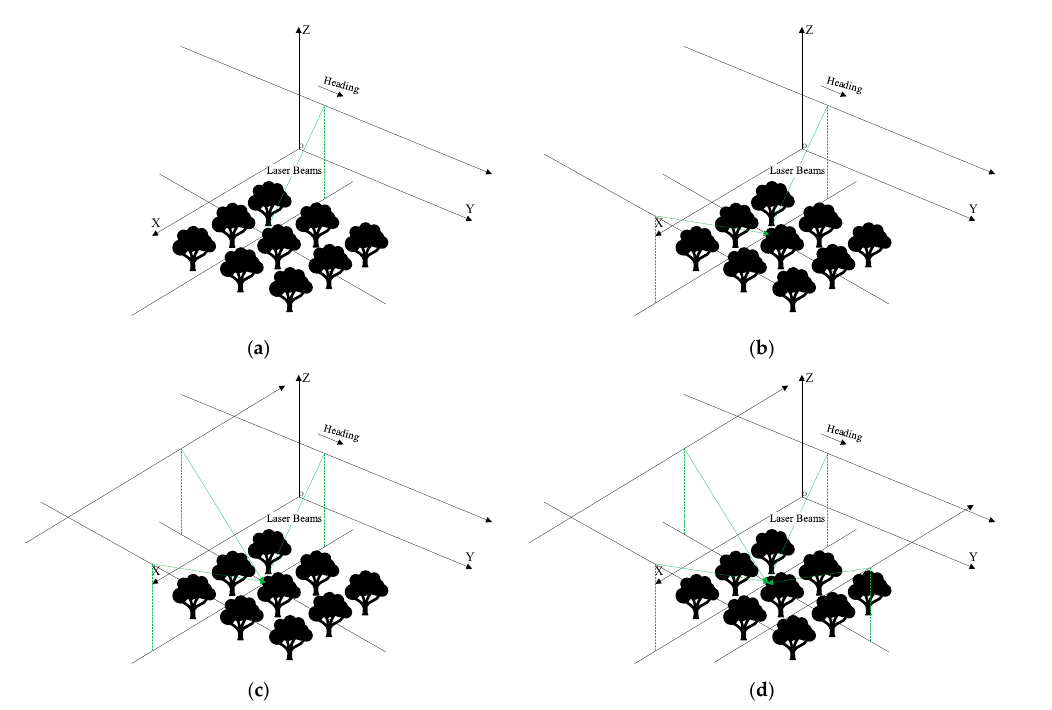
Figure 8. Schematic diagram of different scanning modes: ( a ) single route, ( b ) double routes, ( c ) triple routes, and ( d ) quadruple routes.